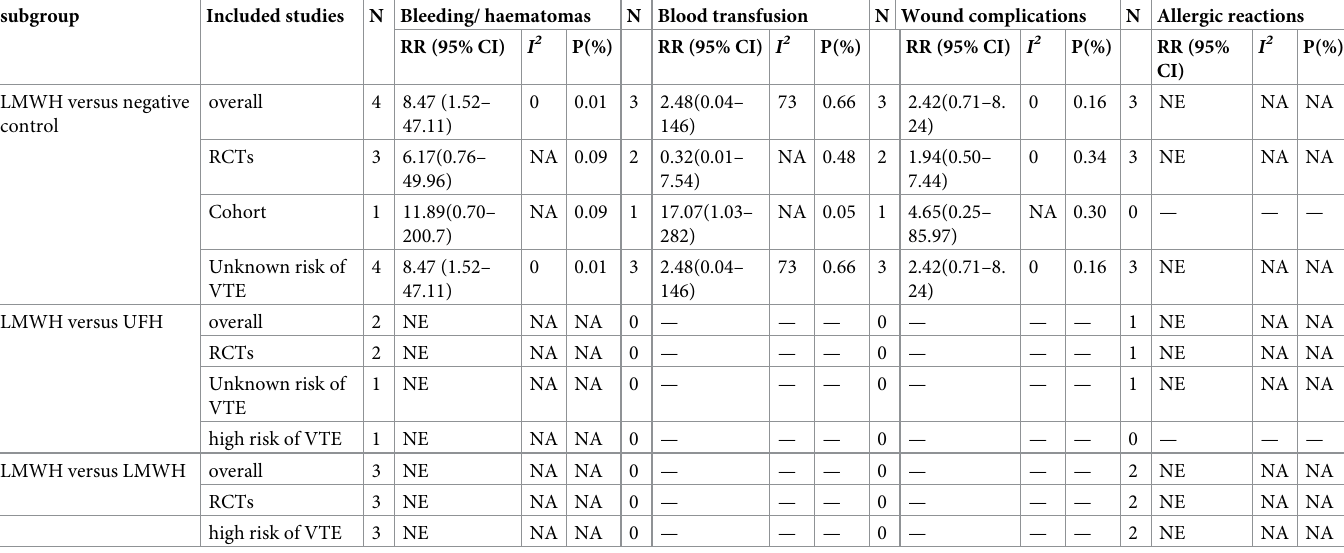
Table 3. Summary of the meta-analysis of thromboprophylaxis safety following CS. subgroup Included studies